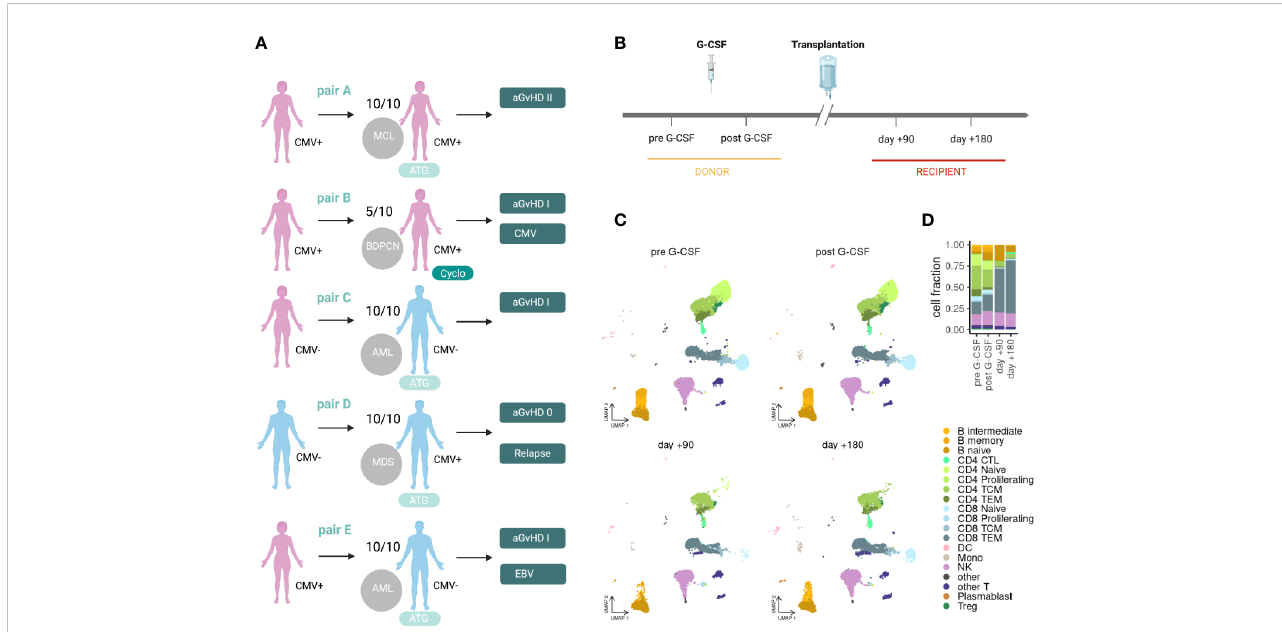
FIGURE 1 Clinical set-up for scRNAseq of PBMCs in alloHSCT. (A) Clinical characteristics of the included donor-recipient pairs. (B) Clinical set-up and sampling time points in the donor (pre G-CSF and post G-CSF) and recipient (day +90 and day +180). (C) scRNAseq data projected into a PBMC reference embedding for different time points before and after alloHSCT. (D) Stacked bar plot summarizing cell type fractions at different stages. MCL, mantle cell lymphoma; BPDCN, blastic plasmacytoid dendritic cell neoplasm; AML, acute myeloid lymphoma; MDS, myelodysplastic syndrome; 10/10, HLA-matched; 5/10, haploidentical; ATG, antithymocyte globuline; Cyclo, cyclophosphamide; aGvHD, acute graft-versus-host disease; CMV, cytomegalovirus; CTL, cytotoxic T lymphocytes; TCM, central memory T-cells; TEM, effector memory T-cells; DC, dendritic cells; Mono, monocytes; NK, natural killer cells; Treg, regulatory T-cells; pre, pre G-CSF; post, post G-CSF; d90, day +90 post transplantation; d180, day +180 post